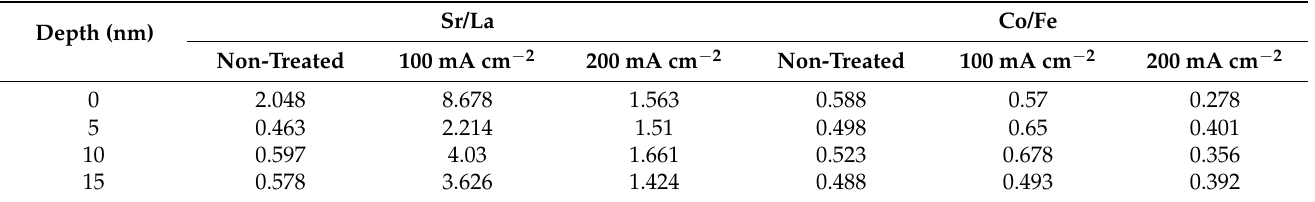
Table 3. Sr/La and Co/Fe ratio determined by XPS for LSCF electrodes after polarization treatment at 750 ◦ C in air for 120 h at different depths (Adapted from Ref.